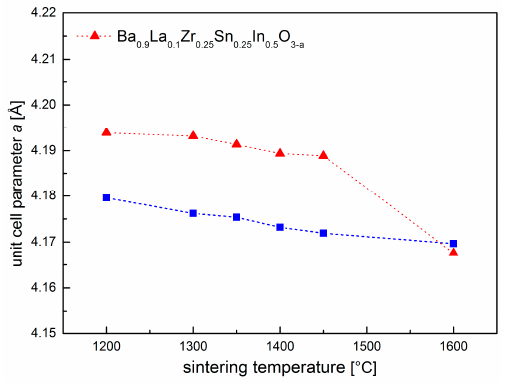
Figure 2. Unit cell parameter a dependence on the sintering temperature for Ba 0.9 La 0.1 Zr 0.25 Sn 0.25 In 0.5 O 3 − a